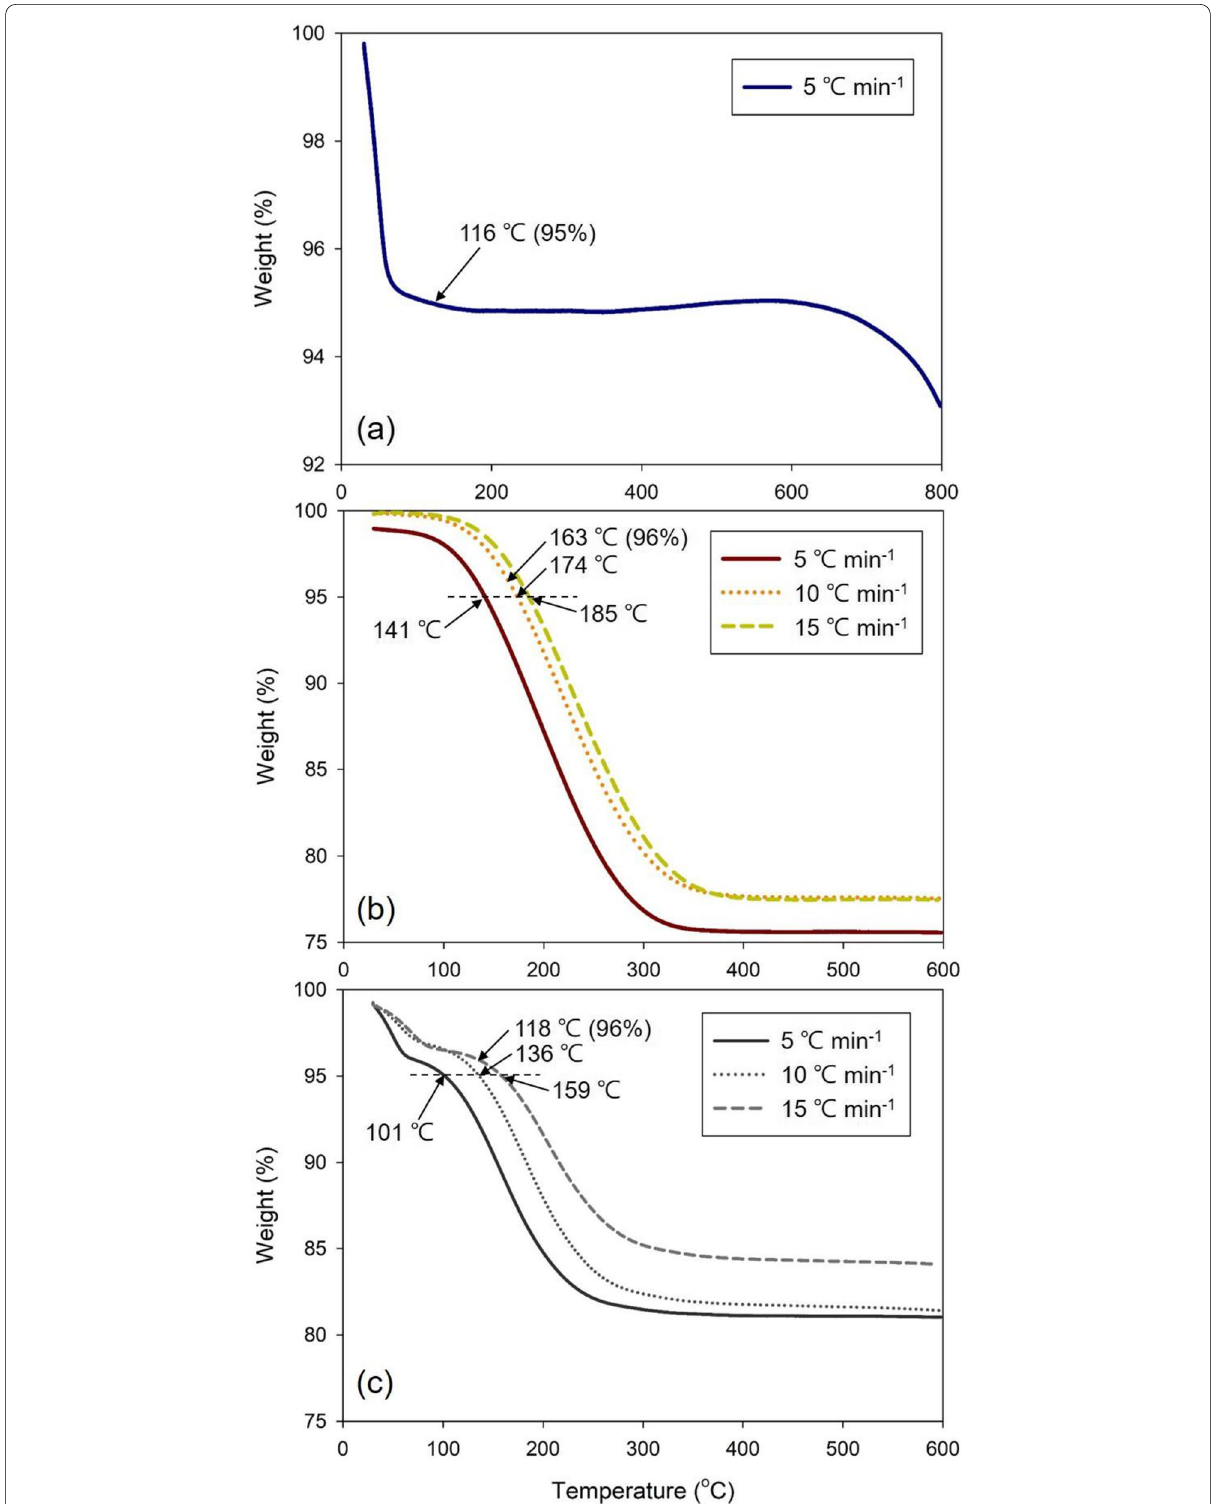
Fig. 6 TGA desorption curves for a virgin KBAC at heating rate of 5 °C min − 1 , b TOL‑KBAC‑160 °C, and c MEK‑KBAC‑160 °C at heating rates of 5, 10, and 15 °C min −